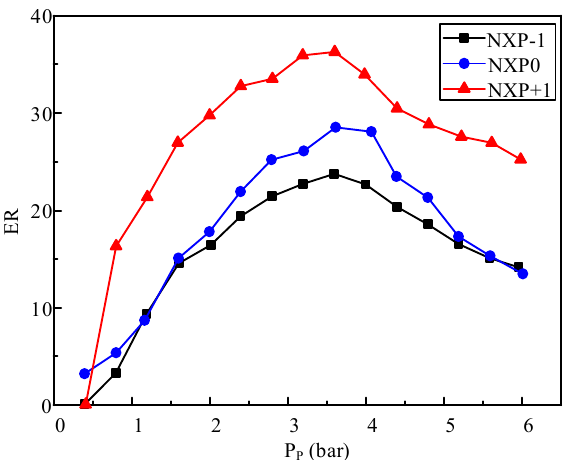
Figure 7. Effects of primary flow pressure on ejector performance at different nozzle exit positions